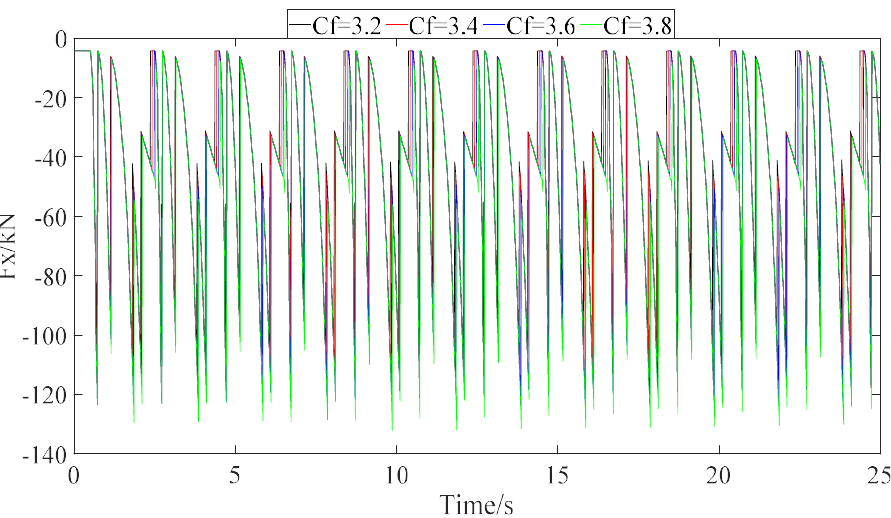
Figure 13. Time history curves of total ice force under different fracture coefficients ( C f ).